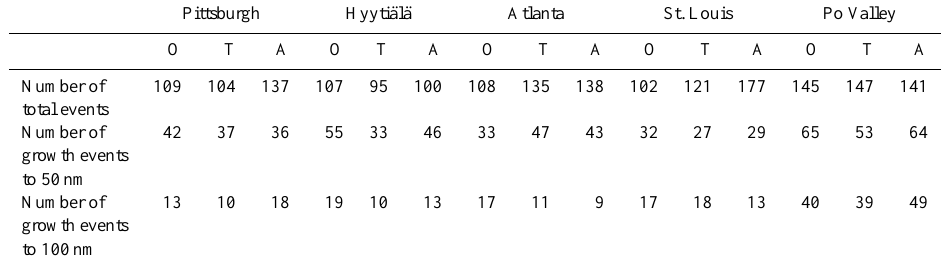
Table 5. Mean values for nucleation event numbers for each site. O = observed, T = ternary simulation, A = activation simulation.